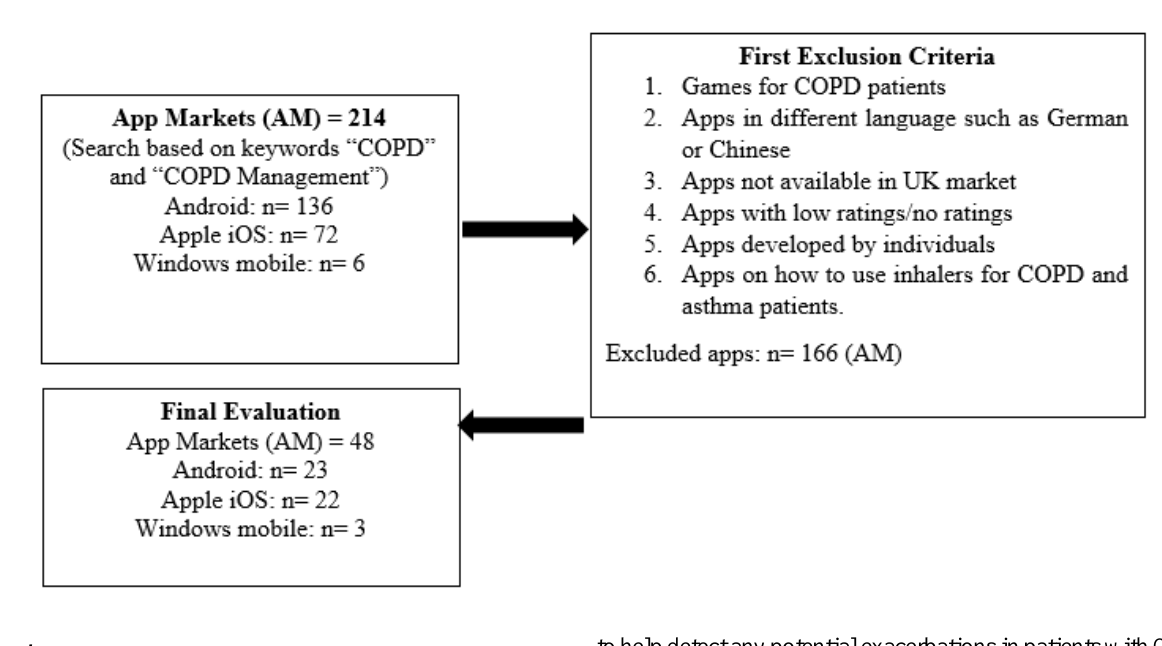
Figure 2. Breakdown of the online markets search